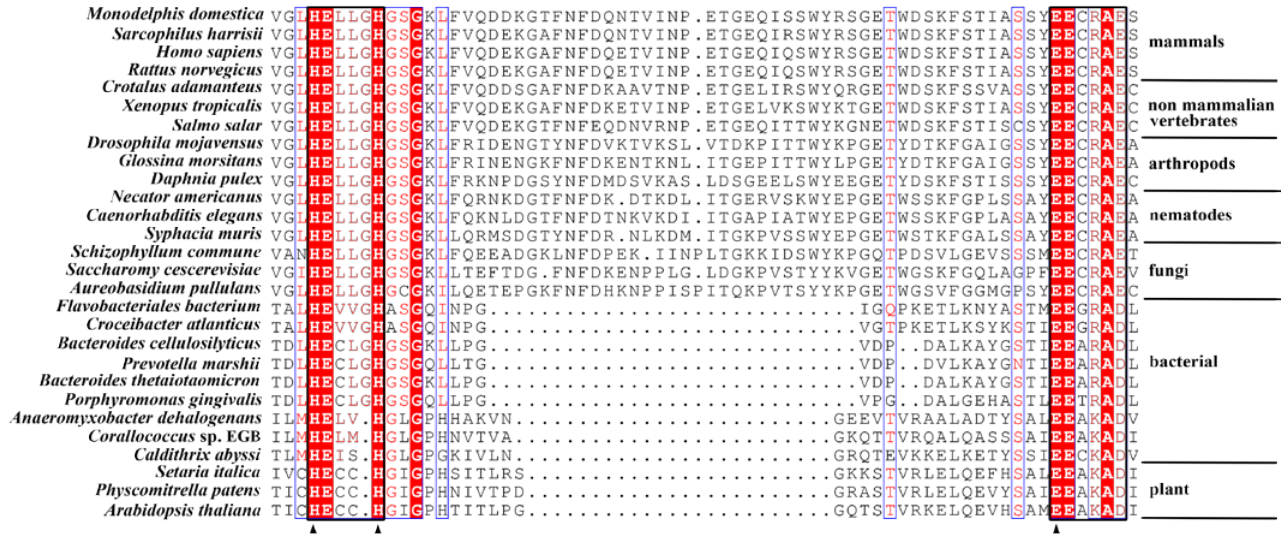
Figure 1. A section of a multiple sequence alignment of DPP III from various species. The organisms and UniProt sequence identifiers are Monodelphis domestica (F6ZXH8), Sarcophilus harrisii (A0A7N4P2W4), Homo sapiens (Q9NY33), Rattus norvegicus (O55096), Crotalus adamanteus (J3RZ30), Xenopus laevis (Q6DE90), Salmo salar (B5X435), Drosophila mojavensis (B4K999), Glossina morsitans (D3TMQ7), Daphnia pulex (E9GTX0), Necator americanus (W2SLT7), Caenorhabditis elegans (G5ECW7), Syphacia muris (A0A0N5AXJ5), Schizophyllum commune (D8PVF6), Saccharomyces cerevisiae (Q08225), Aureobasidium pullulans (A0A074XX23), Flavobacteriales bacterium (A4AQA4), Croceibacter atlanticus (A3U8C5), Bacteroides cellulosilyticus (E2NMV7), Prevotella marshii (E0NQE0), Bacteroides thetaiotaomicron (A0A139KC05), Porphyromonas gingivalis (Q7MX92), Anaeromyxobacter dehalogenans (Q2IN78), Corallococcus sp. EGB (A0A5H1ZR28), Caldithrix abyssi (H1XW48), Setaria italica (K3YPW2), Physcomitrella patens (A9TLP4), and Arabidopsis thaliana (Q8L831). The conserved motifs are marked by rectangular boxes. The triangles show the amino acids involved in zinc ion coordination. Dots indicate gaps. Identical amino acid residues in the same position are shaded.